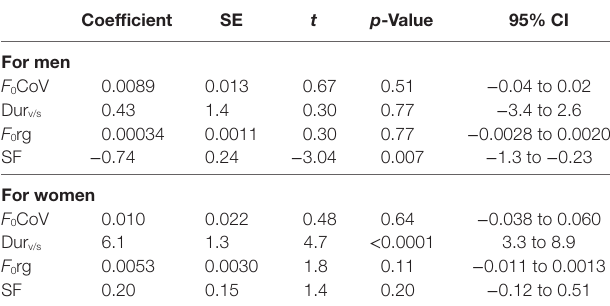
Table 3 | Results of linear regression to identify “prosody acoustic measures”— measures that contributed to listener rating of affective prosody. coefficient